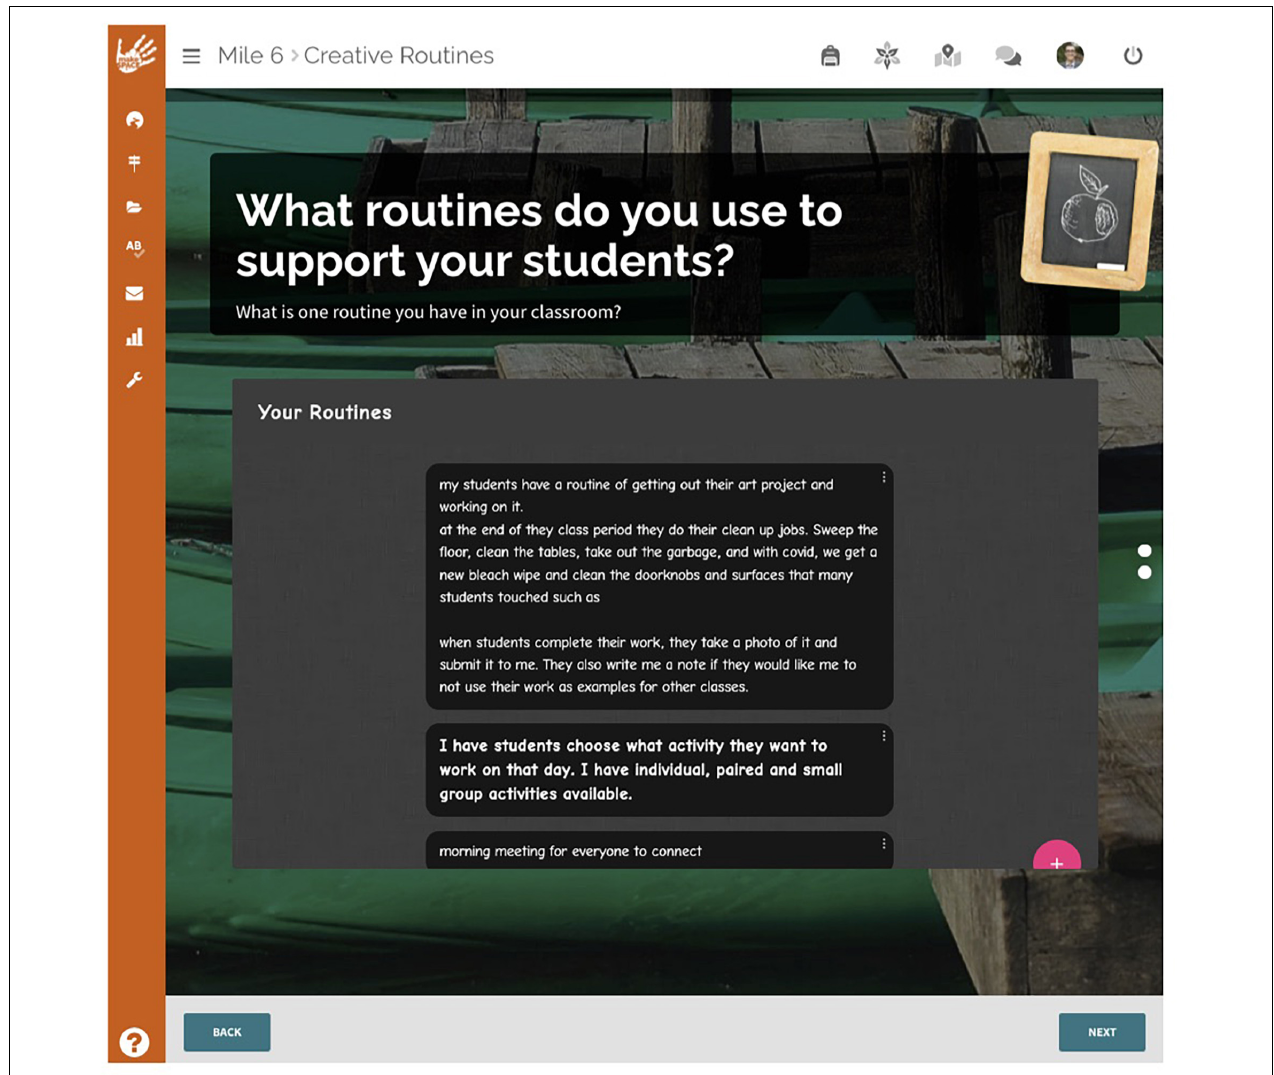
FIGURE 3 | Sample interactive page from online professional development course in creativity and arts integration showing a prompt for teachers to share the routines they use in their